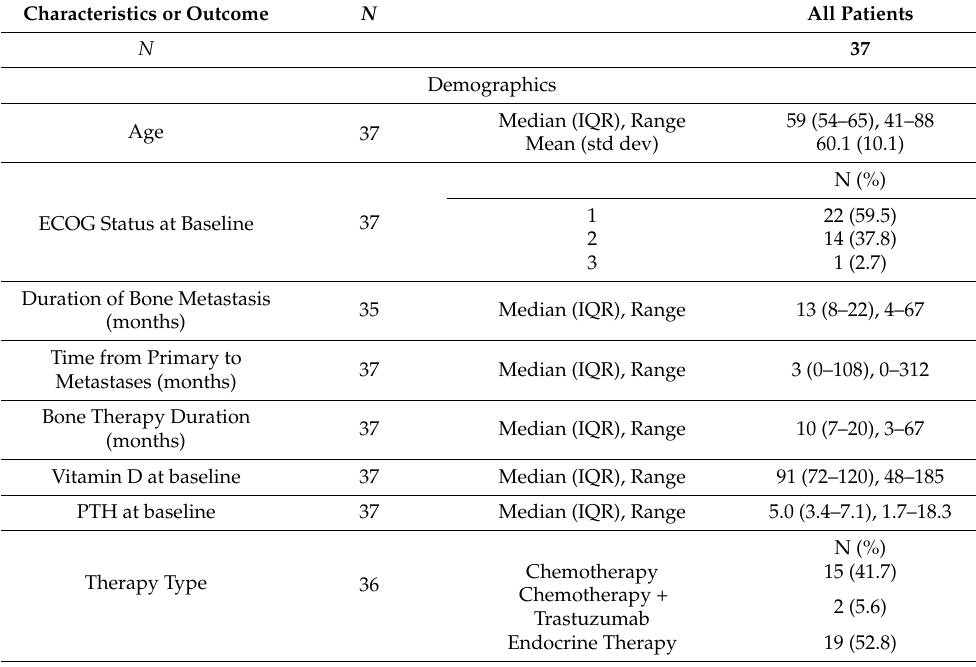
Table 1. Characteristics and